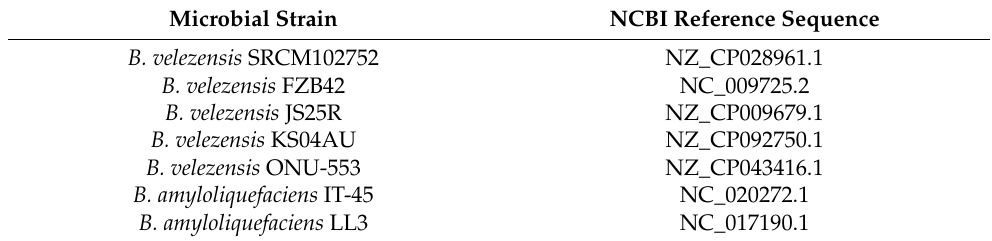
Table 1. Genomes used in this